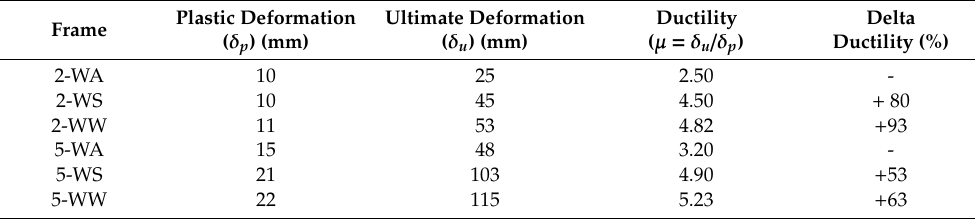
Table 10. Deformations and ductility of the